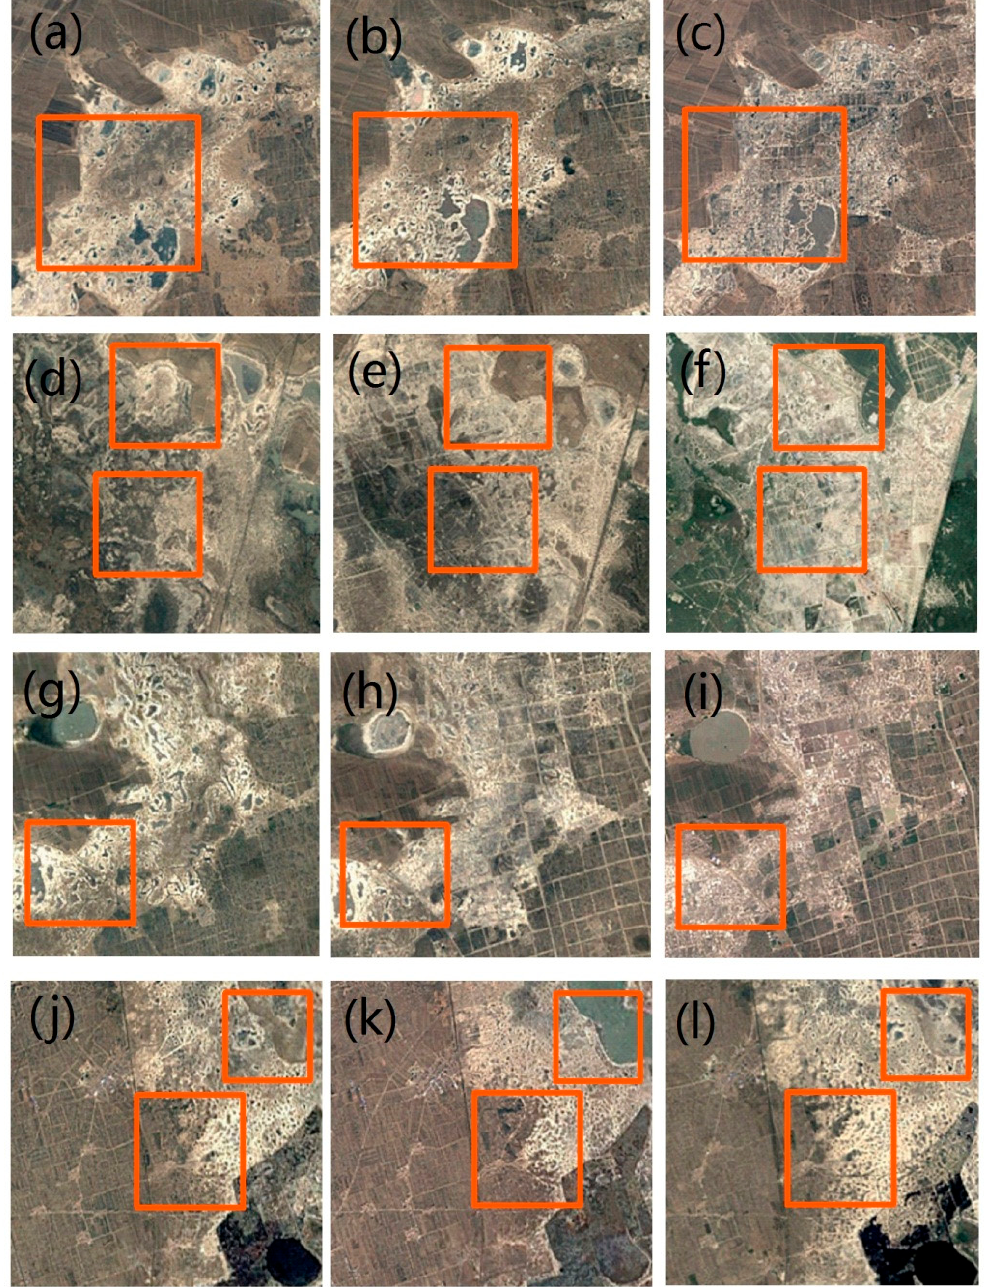
Figure 11. The high-resolution remote sensing images (( a , d , g , j ) obtained in 2000–2004; ( b , e , h , k ) obtained in 2005–2009; ( c , f , i , l ) obtained in 2010–2015) of four different missed pixels (the images of different pixels was placed in different rows). The areas with significant changes are marked by the orange rectangle.